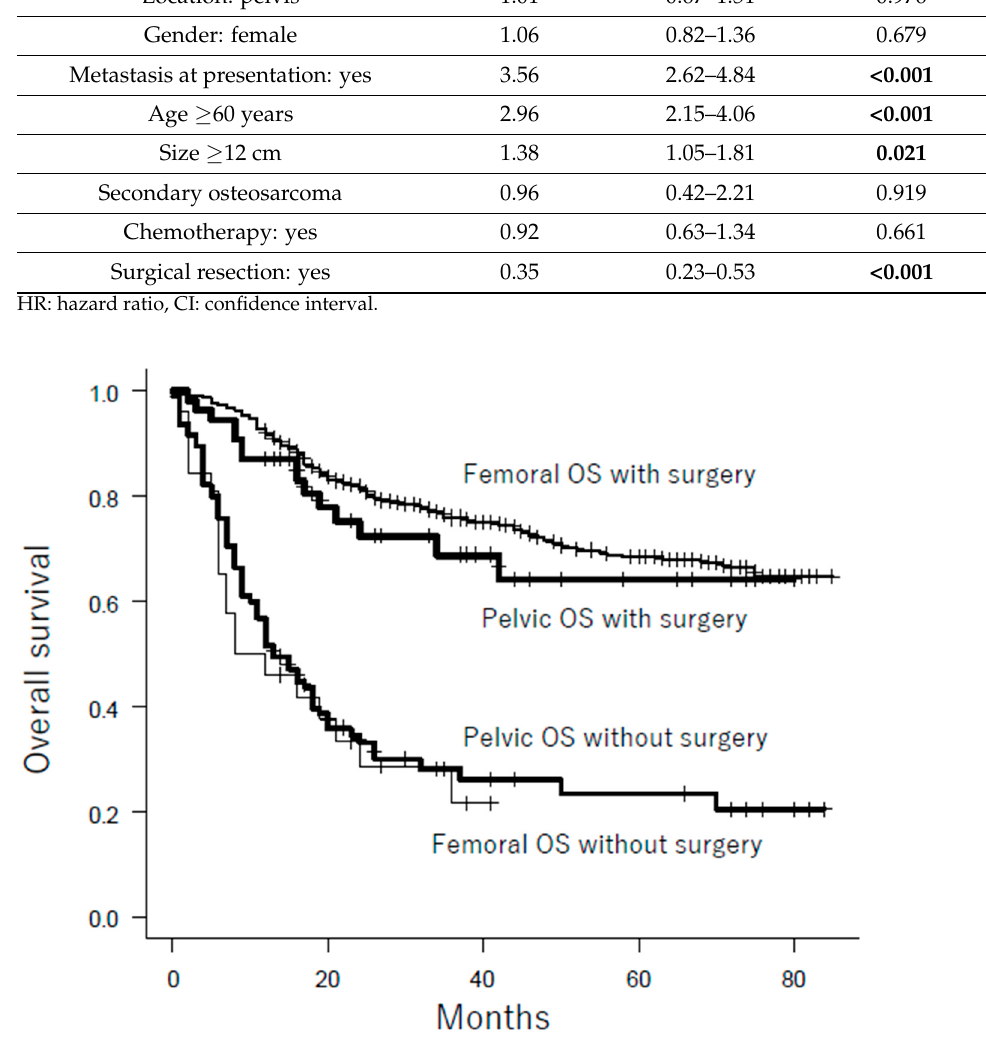
Figure 2. Subgroup analysis of pelvic osteosarcoma and femoral osteosarcoma according to surgical resection. There was no significant difference in overall survival between pelvic osteosarcoma and femoral osteosarcoma in patients who underwent surgical resection ( p = 0.329) and in patients who did not undergo surgical resection ( p = 0.644). OS: